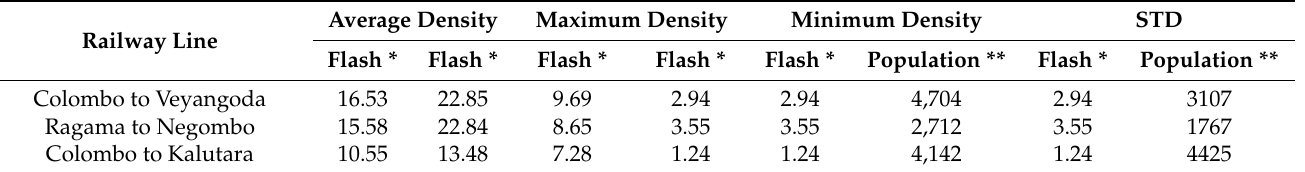
Units: * flashes/(km 2 · year) and ** people km − 2